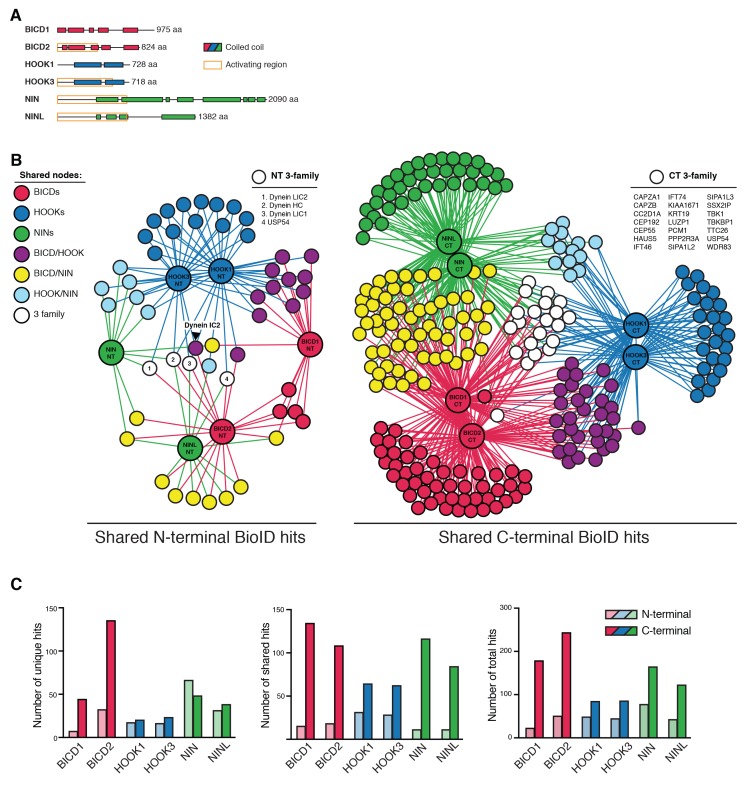
Dynein activators have distinct proteomes.(A) Location of predicted coiled coils in dynein activators, with minimal activating regions shown (orange rectangles). (B) Enriched and significant hits from N- and C-terminal datasets of six activators were used to construct two separate protein-protein interaction networks. Hits specific to an activator family (color-coded according to their respective activators), and hits shared between activator families (HOOK/BICD, purple; BICD/NIN, yellow; NIN/HOOK, cyan) are shown. White spheres (‘3-family’) represent hits enriched in at least one activator from each family. For this figure enrichment is ≥3 fold, significance is p<0.05, Student’s two-tailed t-test; and average spectral counts are ≥2. The location of dynein and dynactin subunits and select hits discussed in the text are indicated. We note that we identified BICD1 in our BICD2 datasets and vice versa (Supplementary files 1 and 4). The same was true for HOOK1 and HOOK3, but not for NIN and NINL (Supplementary files 1 and 4). HOOK proteins have been shown to heterodimerize (Xu et al., 2008), whereas heterodimerization between BICD proteins has not been reported. (C) The number of total, unique (occurring in a single activator N- or C-terminal dataset), and shared (occurring in multiple activator N- or C-terminal datasets) hits for individual activator N- and C-termini are shown.